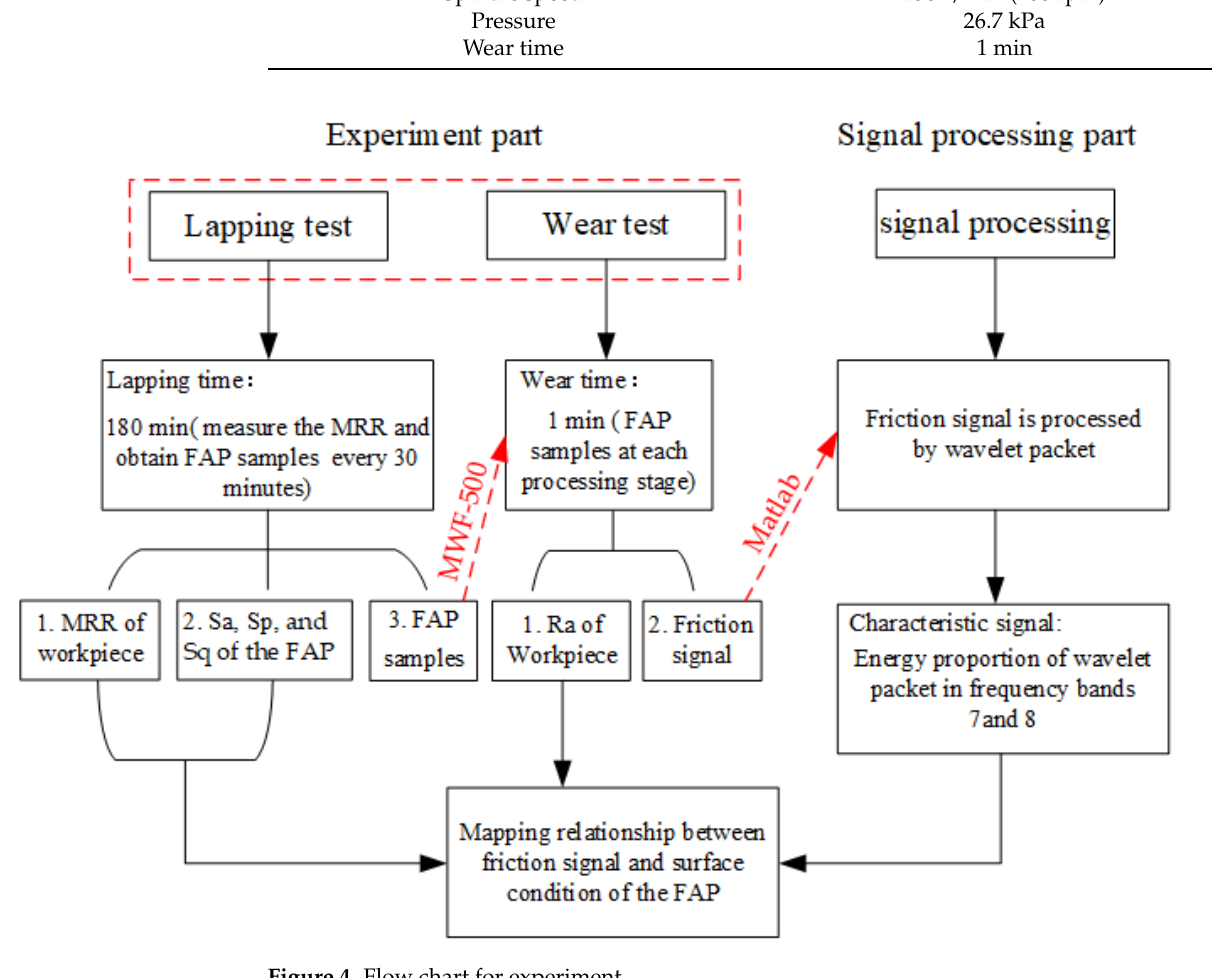
Figure 4. Flow chart for experiment.